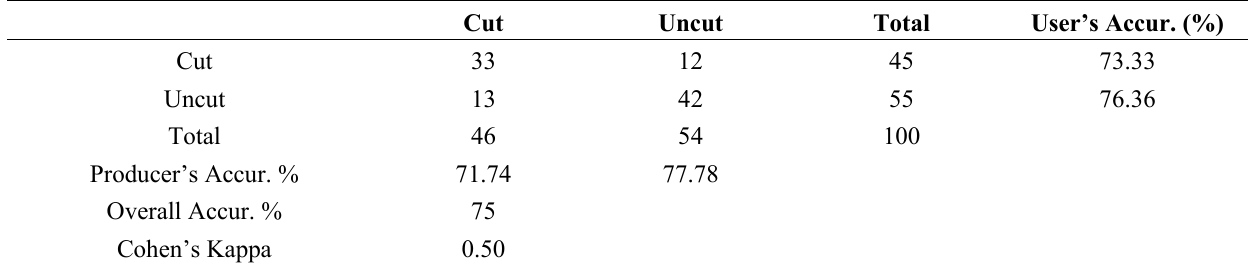
Table 5. Confusion matrix and accuracies of NDVI seasonal statistics data set (16 May to 20 August). Cut Uncut